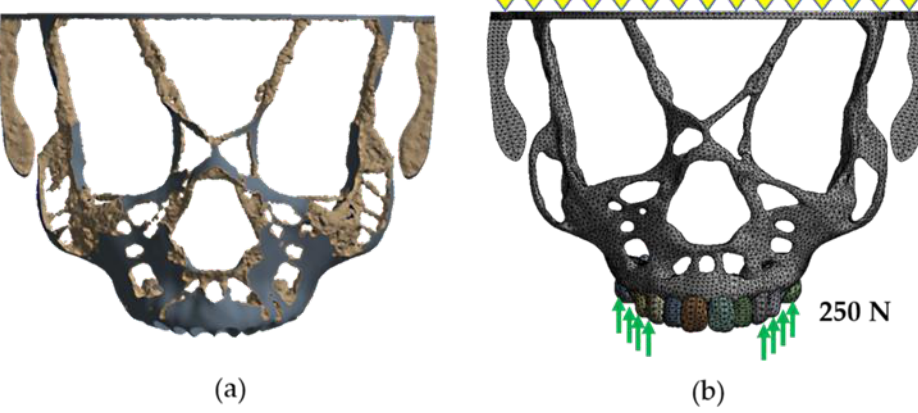
Figure 2. ( a ) The hollow skeleton model with jagged appearance obtained from the topology optimization process; ( b ) model smoothing to refine the jagged boundary profile and generate the optimal structure mesh model with a hollow skeletal (denoted as HS) construction.